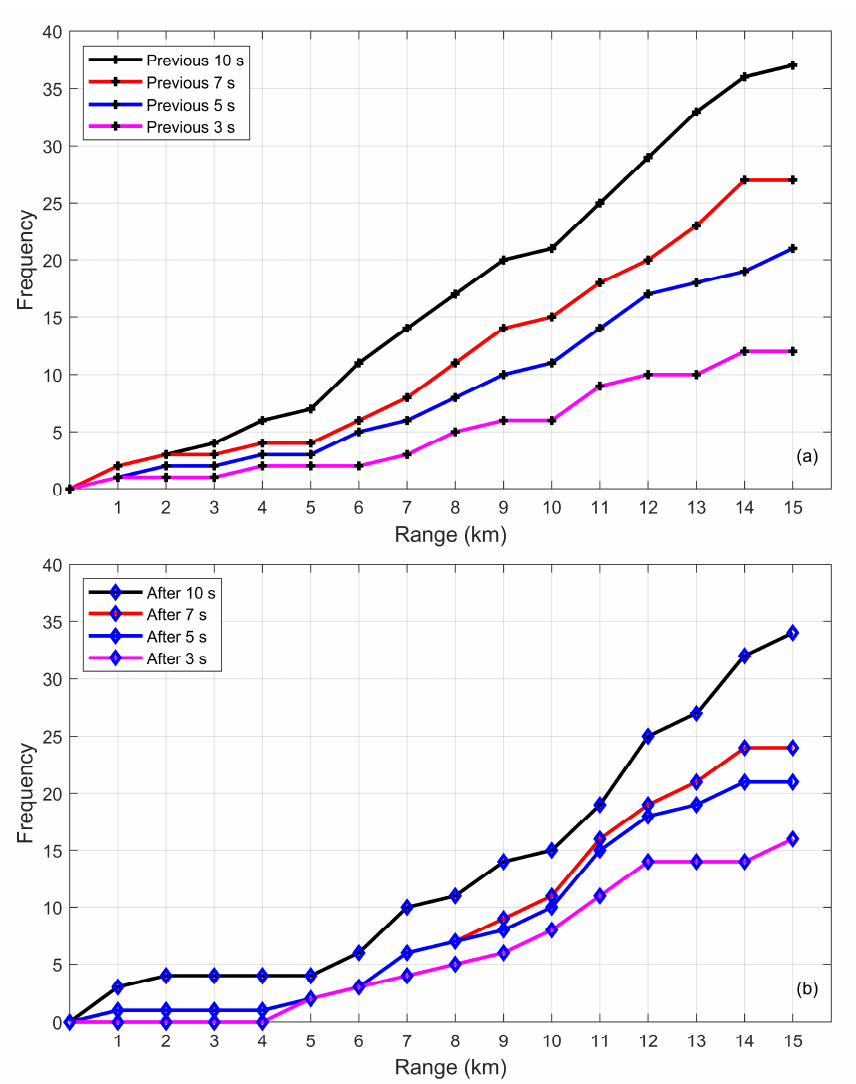
Figure 6. Number of events at different distances from the flash-triggered position and different statistical time length before ( a ) and after ( b ) the